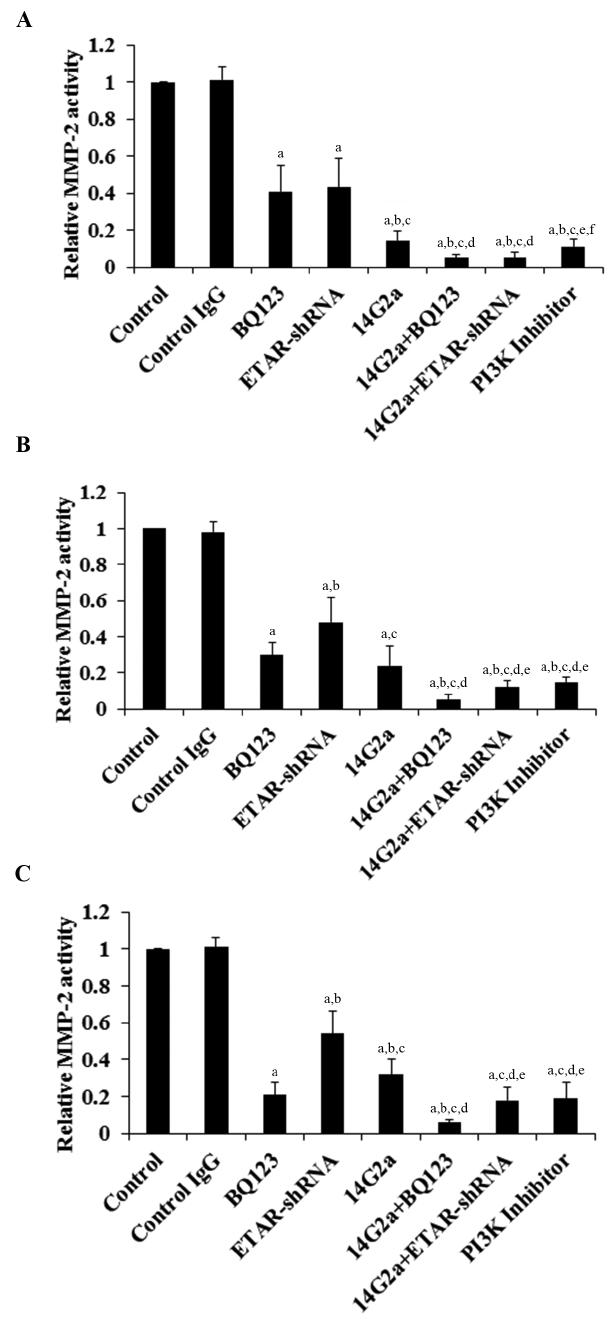
Figure 5. Effects of anti-ganglioside GD2 14G2a monoclonal antibody (mAb) alone or in combination with ET A receptor (ETAR) antagonist on matrix metalloproteinase-2 (MMP-2) activity in osteosarcoma (OS) cells. MMP-2 activities were determined with a SensoLyte 520 MMP-2 Assay Kit (AnaSpec) in Saos- 2 ( A ), MG-63 ( B ) and SJSA-1 ( C ) OS cells treated with control IgG (PK136 mAb, 50 m g/mL), 14G2a mAb (50 m g/mL), selective ETAR antagonist BQ123 (5 m M), and 14G2a (50 m g/mL) + BQ123 (5 m M) for 48 hours. Cells with knockdown of ETAR (ETAR-shRNA) with or without 14G2a mAb treatment were also tested. Cells treated with selective phosphatidy- linositide 3-kinase (PI3K) inhibitor BKM120 (50 m M) was used as a positive control. The MMP-2 activity was shown as fold changes to that of the untreated control cells (designated as 1). Each experiment was repeated for three times in duplicates. Data values were expressed as Mean + SD. a p , 0.05 vs. control or control IgG; b p , 0.05 vs.